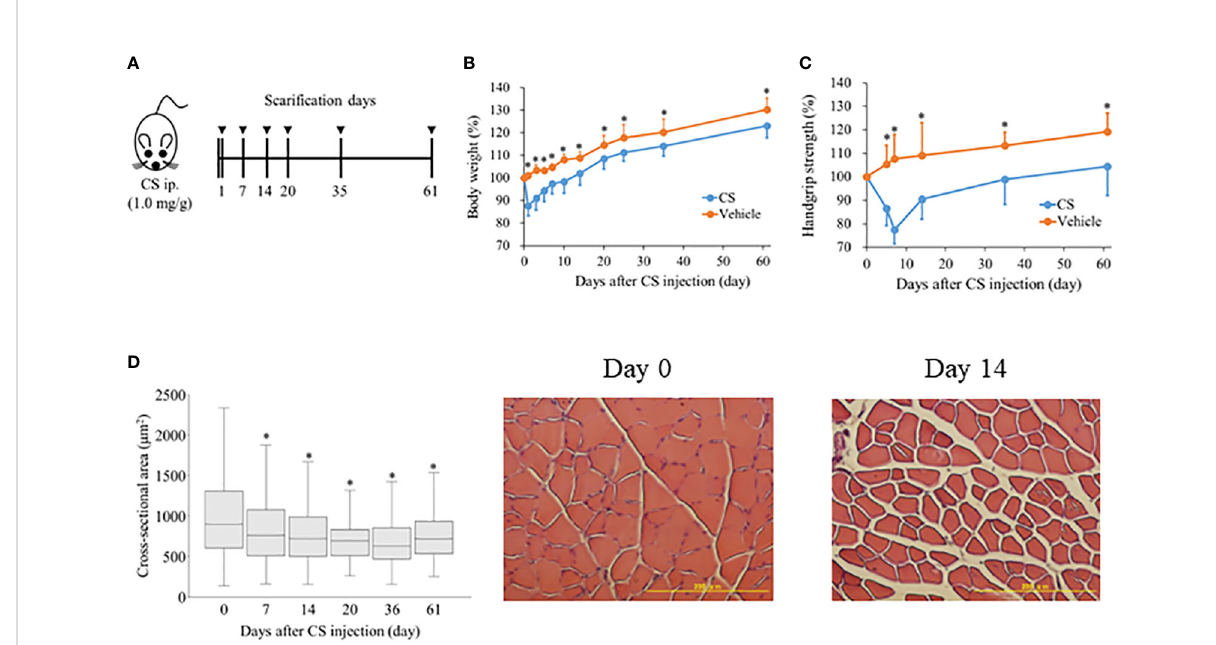
FIGURE 1 Sepsis decreases body weight, grip strength, and muscle atrophy in mice. (A) Shema showing study design. Mice were injected 1.0 mg/g of CS intraperitoneally and body weight, grip strength were evaluated from day 1 to 61 (n = 9 in control, n = 22 in CS). To measure cross-sectional area of the anterior tibialis, mice were sacri fi ced on days 7, 14, 20, 35, and 61 after CS injection. (B) Body weight was measured with the sample size (CS/control) at day 0 (22/9), 1 (22/9), 3 (19/8), 5 (19/8), 7 (19/8), 10 (16/7), 14 (16/7), 20 (13/6), 25 (13/6), 35 (13/6), and 61 (10/5). (C) Grip strength was measured with the sample size (CS/control) at 0 (20/8), 5 (20/8), 7 (20/8), 14 (17/8), 35 (11/6), and 61 (8/5). (D) Histological change in the cross-sectional area of anterior tibialis following sepsis induction. Cross-sectional area of the anterior tibialis decreased after sepsis induction. * Statistical signi fi cance at p < 0.05 versus